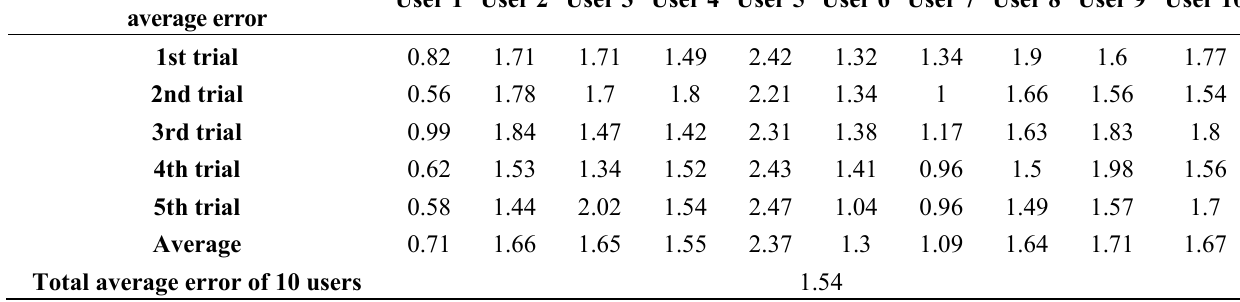
Table 10. The gaze detection errors from the previous method [30] for users who were wearing glasses (units: